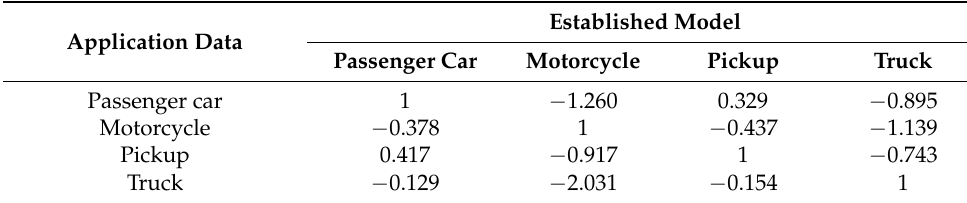
Table 6. The calculation results of model